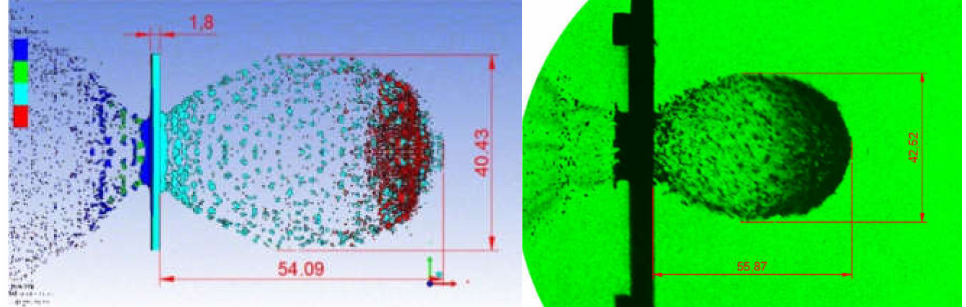
Figure 3. Comparison of numerical-simulation results and experimental results for protective struc- tures under the same working conditions (5 km/s, 20 µ s